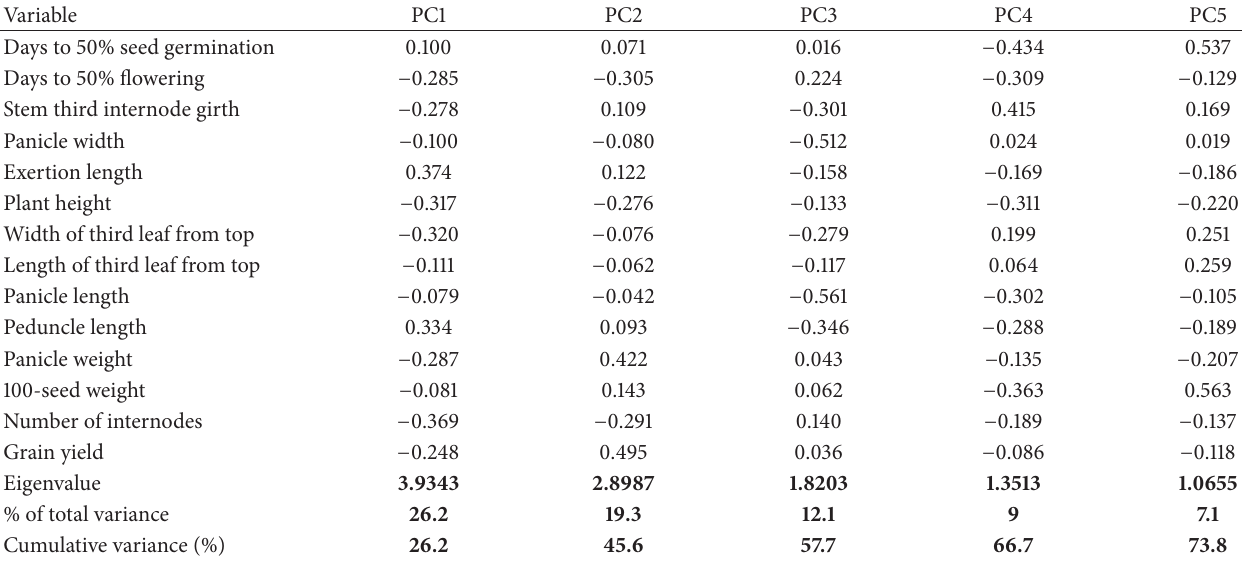
Table 3: Principal component analysis (PCA) of different quantitative agromorphological traits in sorghum.